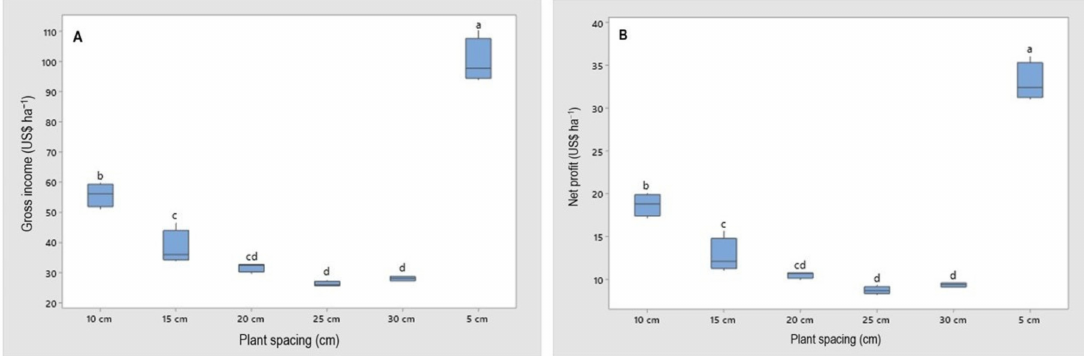
Figure 5. The response of gross income ( A ) and net profit ( B ) of strawberry production cv. ‘Pircinque’ depending on the different spacing between plants with average of the 2018/2019 and 2019/2020 harvests. For each spacing, the different letters indicate significant differences ( p ≤